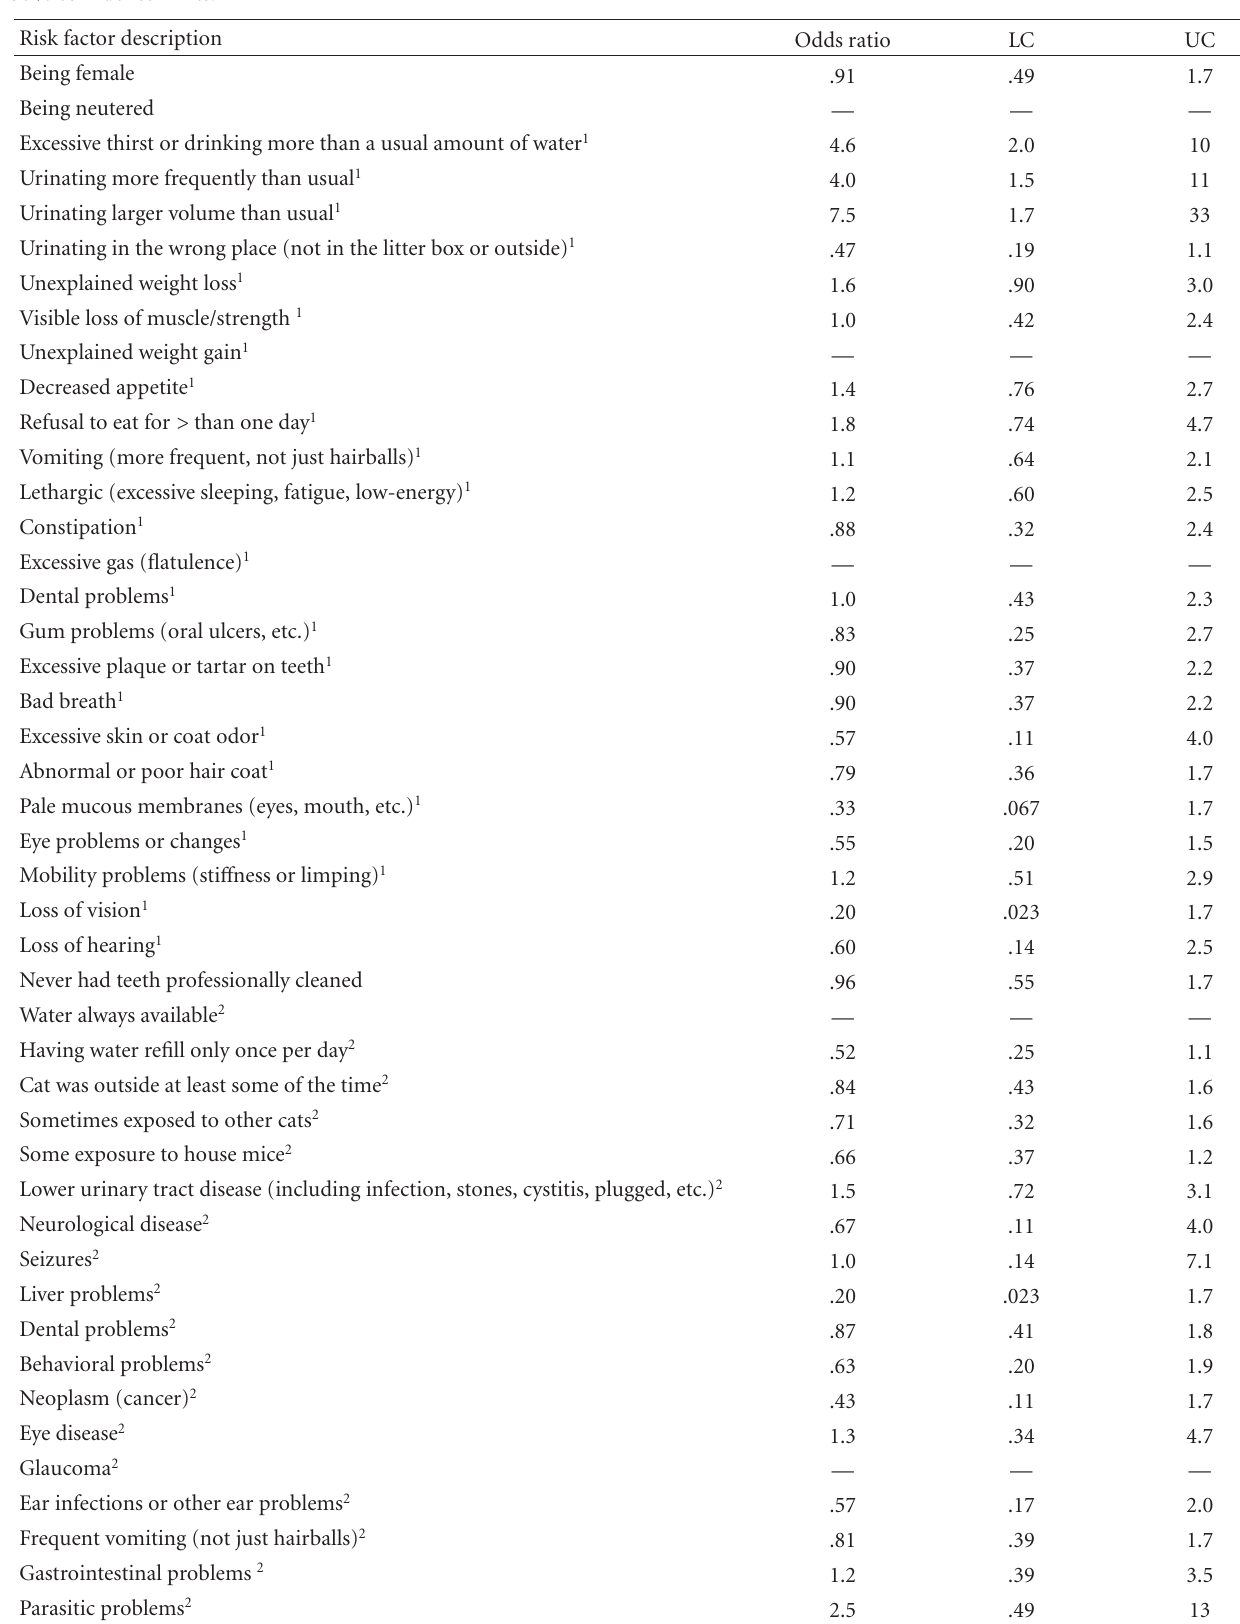
Table 1: Feline-matched case-control odds ratios for dichotomous owner-reported risk factors for CKD, with lower (LC) and upper (UC) 95% confidence